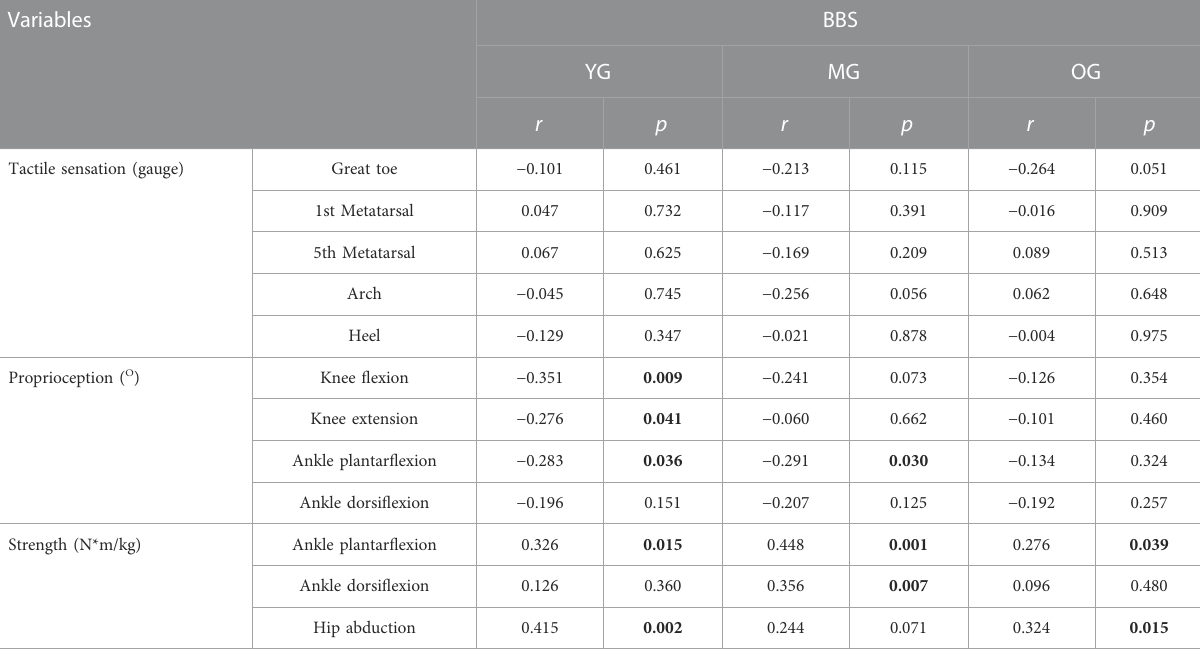
TABLE 3 The age-speci fi c correlations of BBS with muscle strength, tactile sensation, and proprioception. Variables